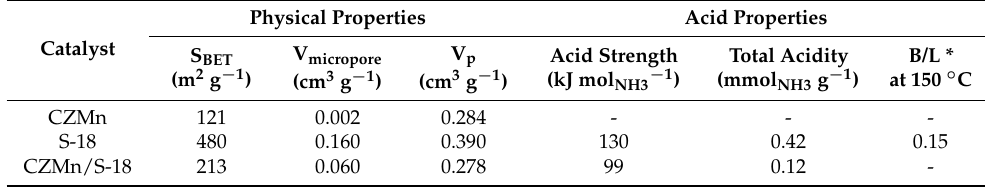
Table 1. Physical and acid properties of the individual metallic and acid functions and of the bifunctional catalyst.